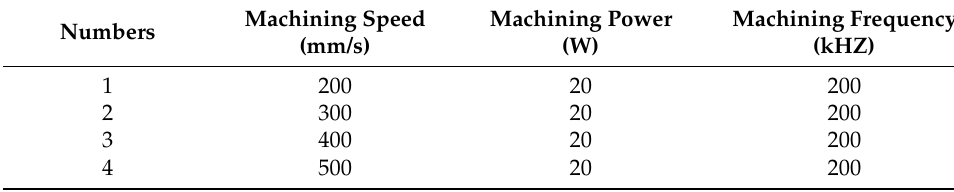
Table 3. Process parameters of laser processing—Speed.